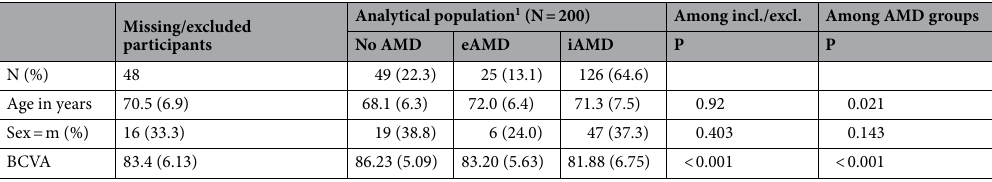
Table 1. Characteristics of the study population. SD standard deviation, IQR interquartile range, AMD age-related macular degeneration, eAMD early AMD, iAMD intermediate AMD, BCVA best-corrected visual acuity. 1 For 180 individuals, both eyes were included; for 20 individuals only one eye was included.